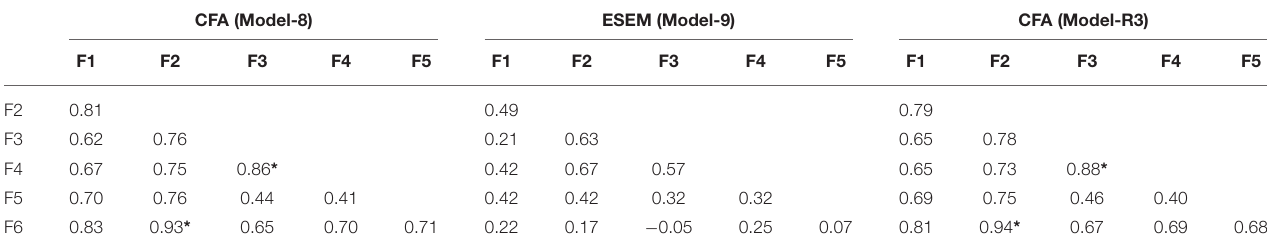
TABLE 5 | Confirmatory factor analysis and exploratory structural equation modeling standardized factor correlations based on the EOQ. CFA (Model-8)